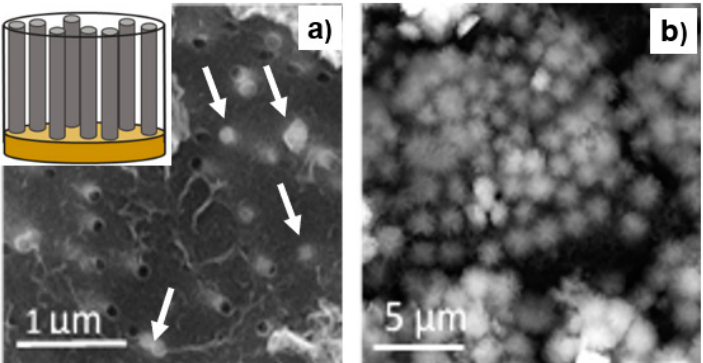
Figure 5. Scanning electron microscopy images of the membrane surface with a Fe nanowire depo- sition that stopped when the nanowires reached the membrane surface ( a ) and then continued up to the formation of the over-deposited caps ( b ). The arrows indicate the nanowires which reached the membrane surface. The scheme shows nanowires in the membrane, standing on the copper con- tact layer.